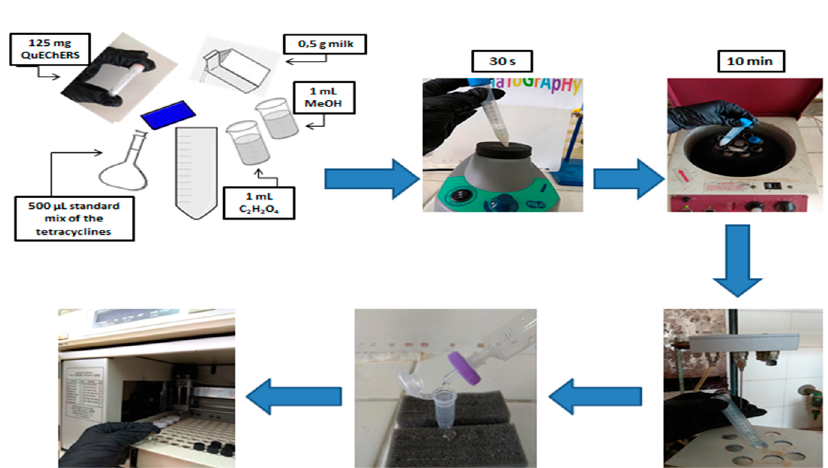
Figure 1. Application of the method in milk samples.